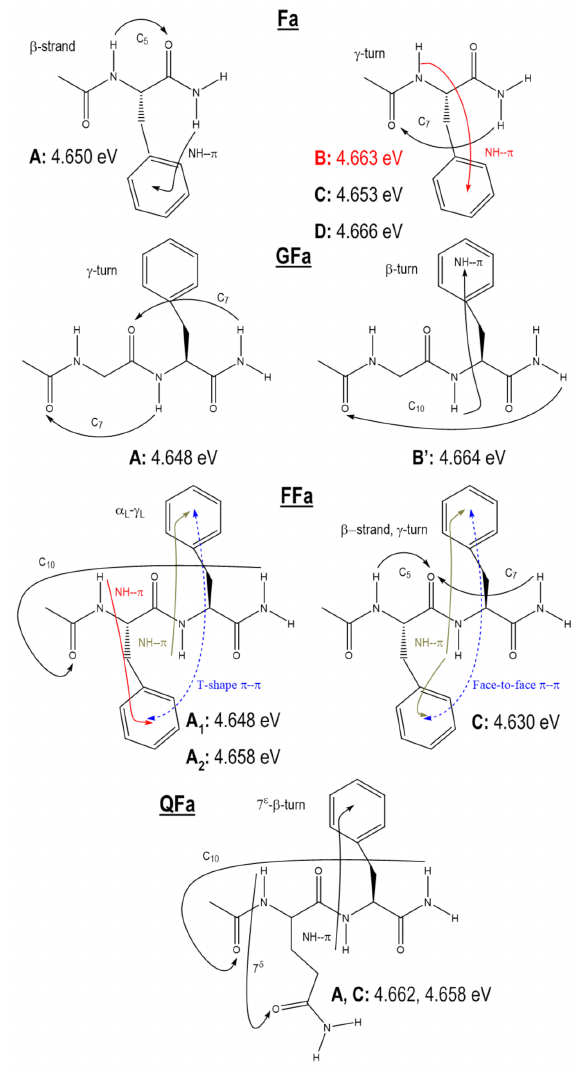
Figure 1. Ac-Phe-NH 2 (Fa) and Ac-X-Phe-NH 2 with X = Gly, Phe, Gln (GFa, FFa, and QFa, respec- tively) conformers and their experimental 0–0 transition energies (eV). Arrows indicate non-covalent intramolecular bonds (hydrogen bonds (C 5 , C 7 , and C 10 ), NH- π bonds, and phenyl ring–ring ar- rangements). Letters A, B, . . . refer to the notation adopted in the experimental reports to designate the conformers observed, which correspond to different types of backbone folding and non-covalent interactions (see the Methods section for a detailed description). In the case of several S 0 conformers, which present both similar backbone folding and non-covalent networks, a single quotation mark is put to distinguish them, such as B and B’. In the case of several S 1 conformers whose conformations have been obtained from the geometry optimization of the same S 0 conformer but correspond to dif- ferent excitation such as excitation via each chromophore, a number is put in subscript to distinguish them, such as A 1 and A 2